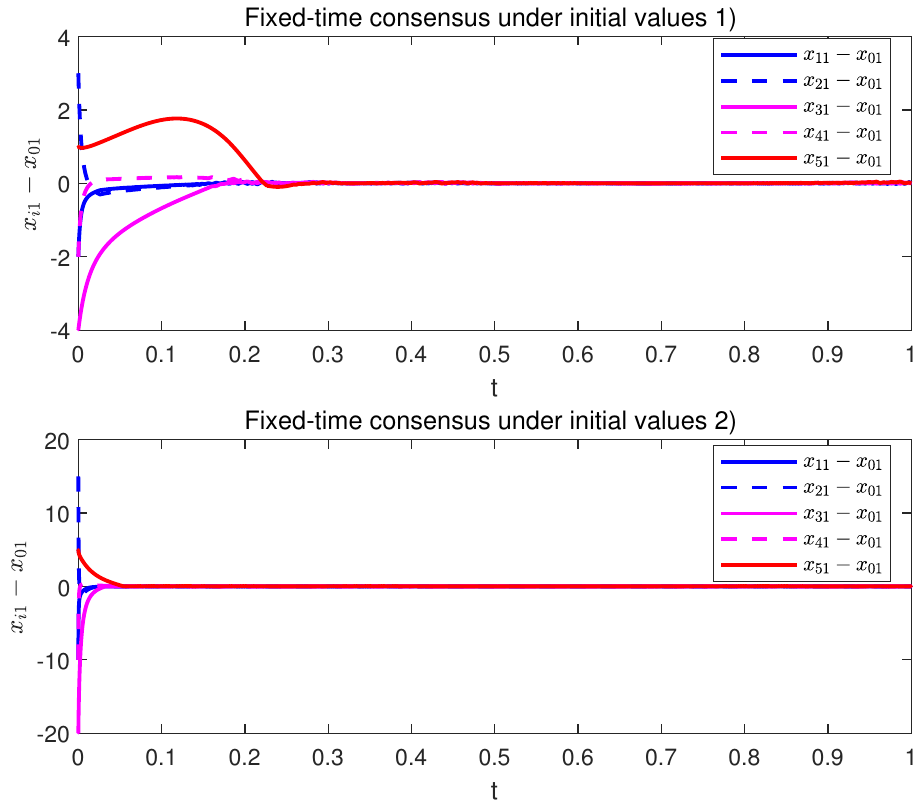
Figure 3. The trajectories of x i 1 for leader-following example under initial values (1) and (2).